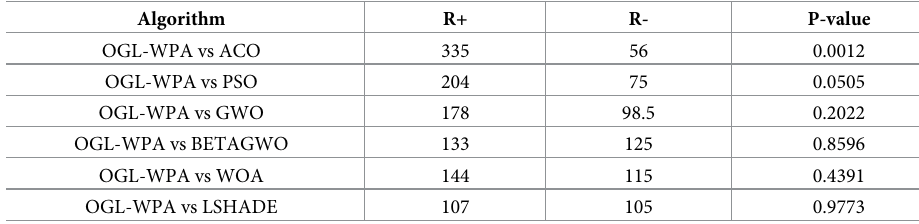
Table 5. Analysis of Wilcoxon statistical test